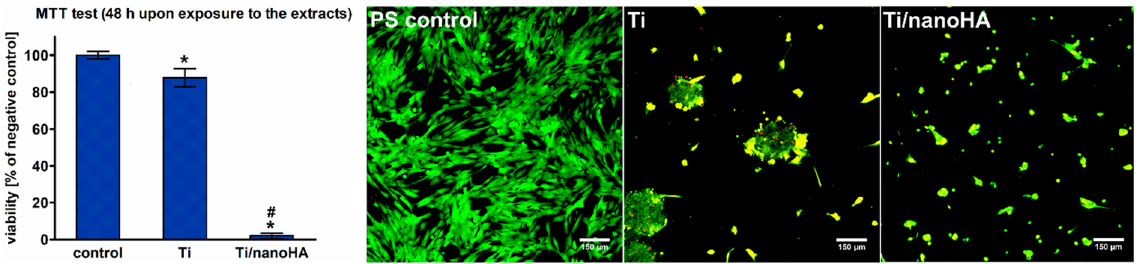
Figure 5. The graph on the left shows cytotoxicity of the materials extracts determined according to the ISO 10993-5 by the MTT test (* significantly different results compared to the negative control of cytotoxicity, # significantly different results compared to the reference Ti13Zr13Nb alloy, according to a one-way ANOVA test followed by Tukey’s multiple comparisons test, p < 0.05); Confocal microscope images present live/dead double-fluorescent staining of hFOB 1.19 osteoblasts cultured for 48 h on the materials surfaces (reference Ti13Zr13Nb – image in the middle; nanoHAp/nanoAg/nanoCu coating – image on the right) and polystyrene (PS) well (healthy control cells; image on the left); viable cells—green fluorescence and dead cells—red fluorescence, 100×, scale bar = 150 µm.